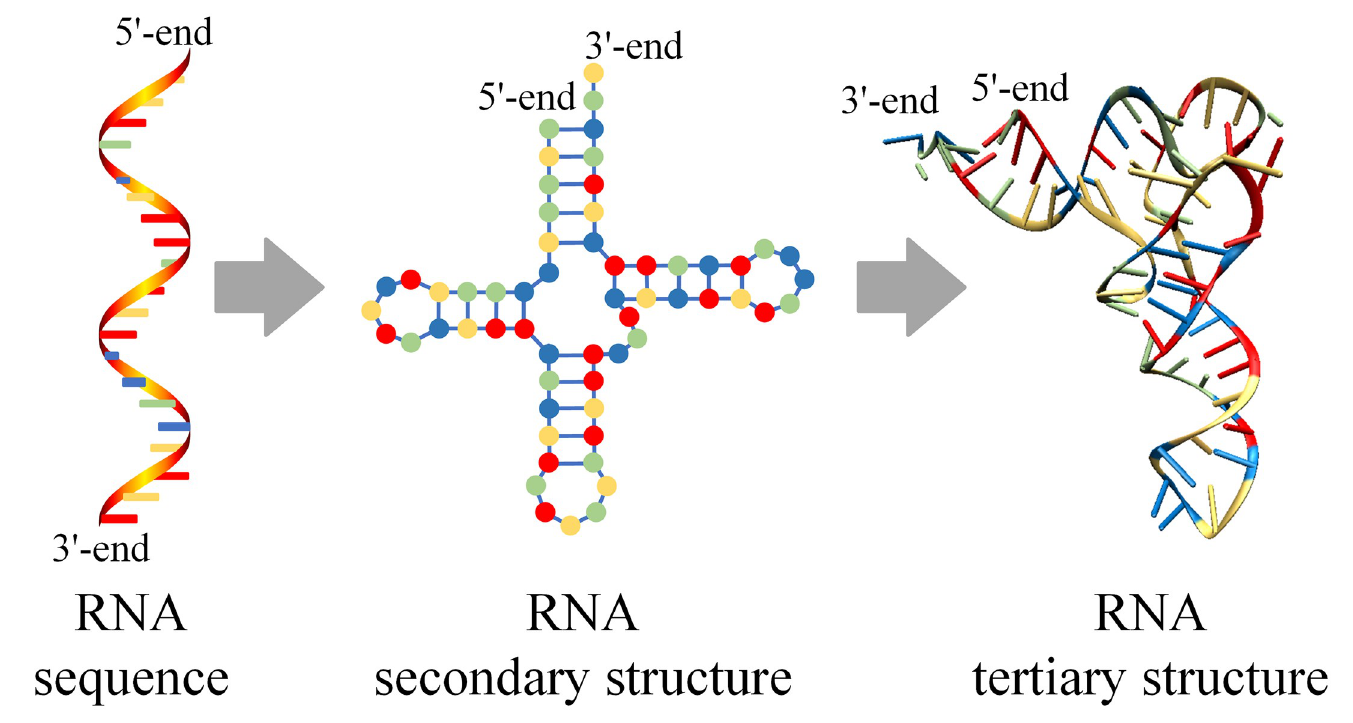
Fig 1. RNA primary (left), secondary (middle), and tertiary structures (right). The RNA folding process is hierarchical, i.e., the RNA secondary structure forms rapidly from linear RNA (primary structure) with a large energy loss, while the formation of a complex tertiary structure is usually much